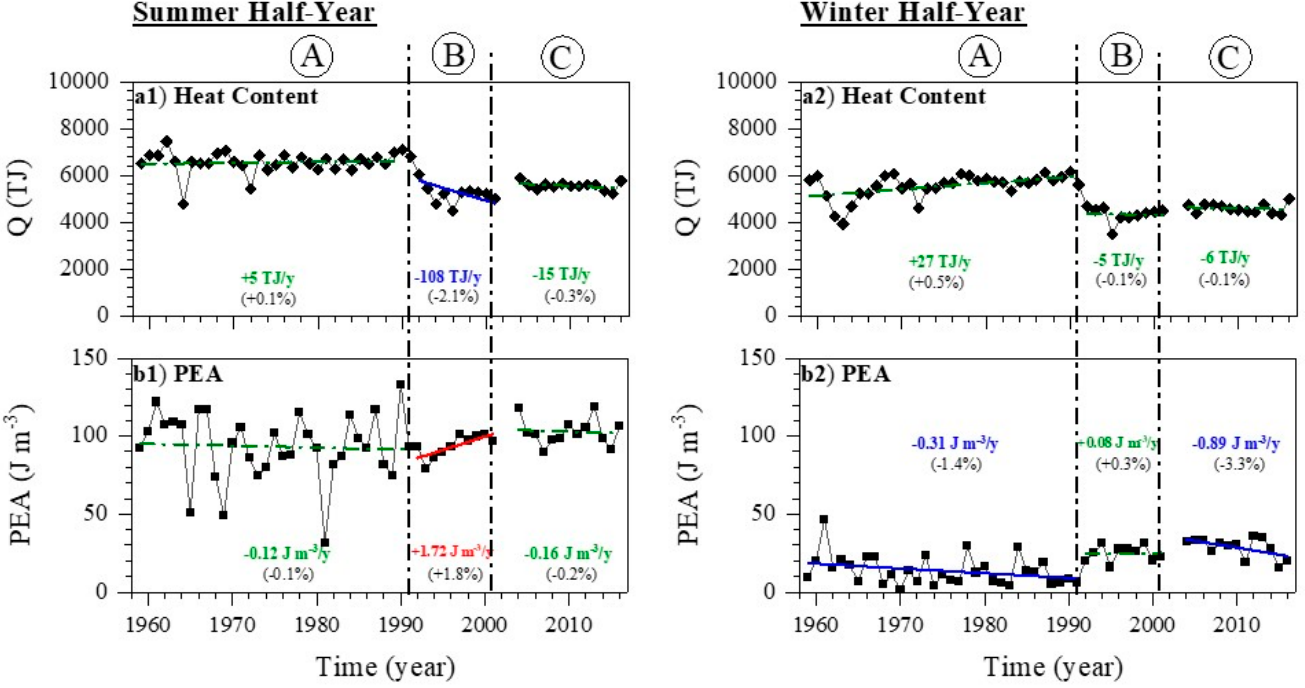
Figure 7. Time series plots of different thermal structure parameters such as ( a1 , a2 ) heat content (Q) and ( b1 , b2 ) potential energy anomaly (PEA). Colored straight lines are linear fit for each period, with red representing a strong positive slope (m ≥ +1%), blue for a strong negative slope (m ≤ − 1%), and green for a weak slope ( − 1% > m > +1%). Colored texts are slopes, while values in parentheses are slope percentages (slope value/average value for that period × 100).